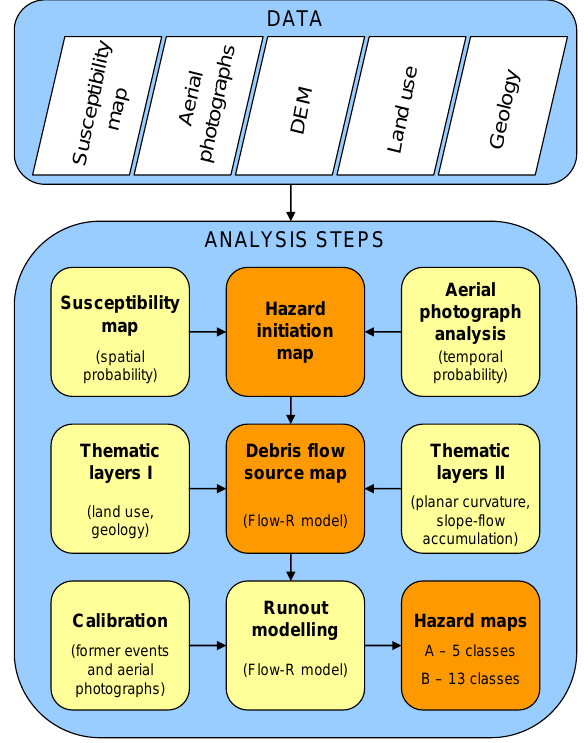
Figure 2. Flowchart of the applied analysis method. Light boxes show modelling inputs and the dark boxes show intermediate and final results.